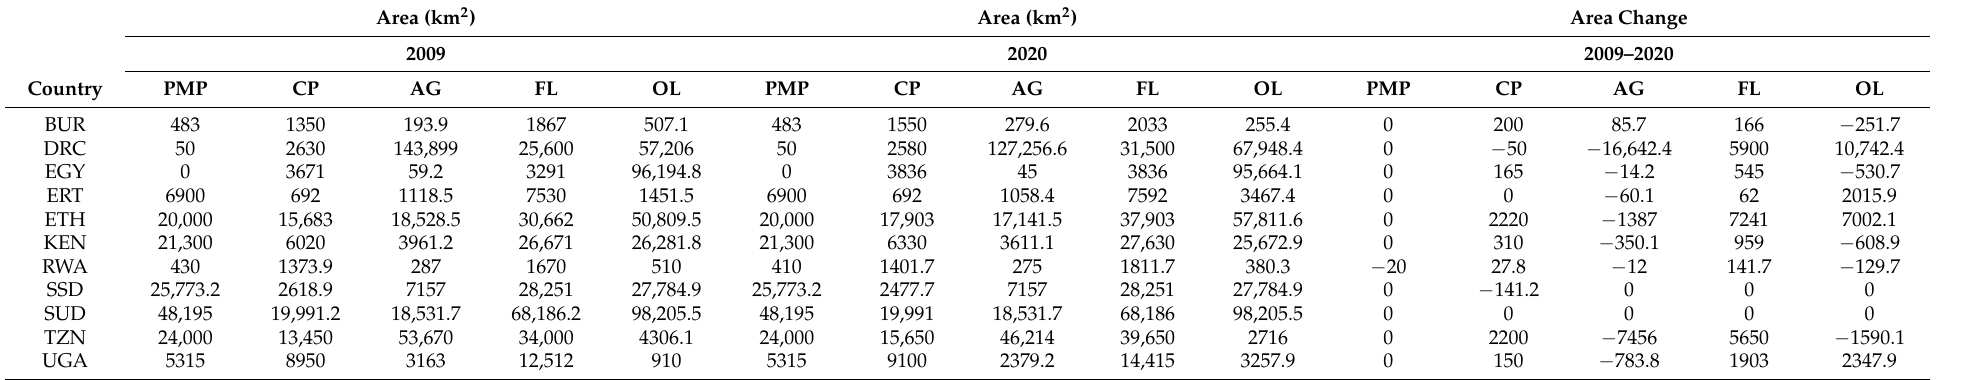
Table 2. Land-use variation in the NRB countries from